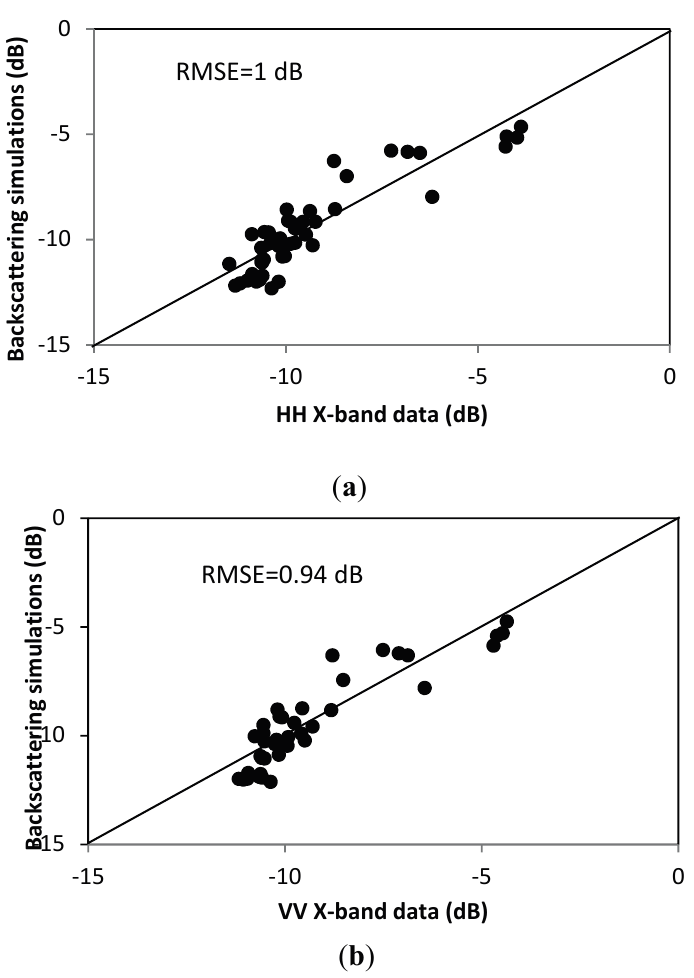
Figure 7. Validation of the empirical model used to simulate radar signal strength at 36° incidence, as a function of soil moisture and soil roughness: ( a ) HH polarization; ( b ) VV